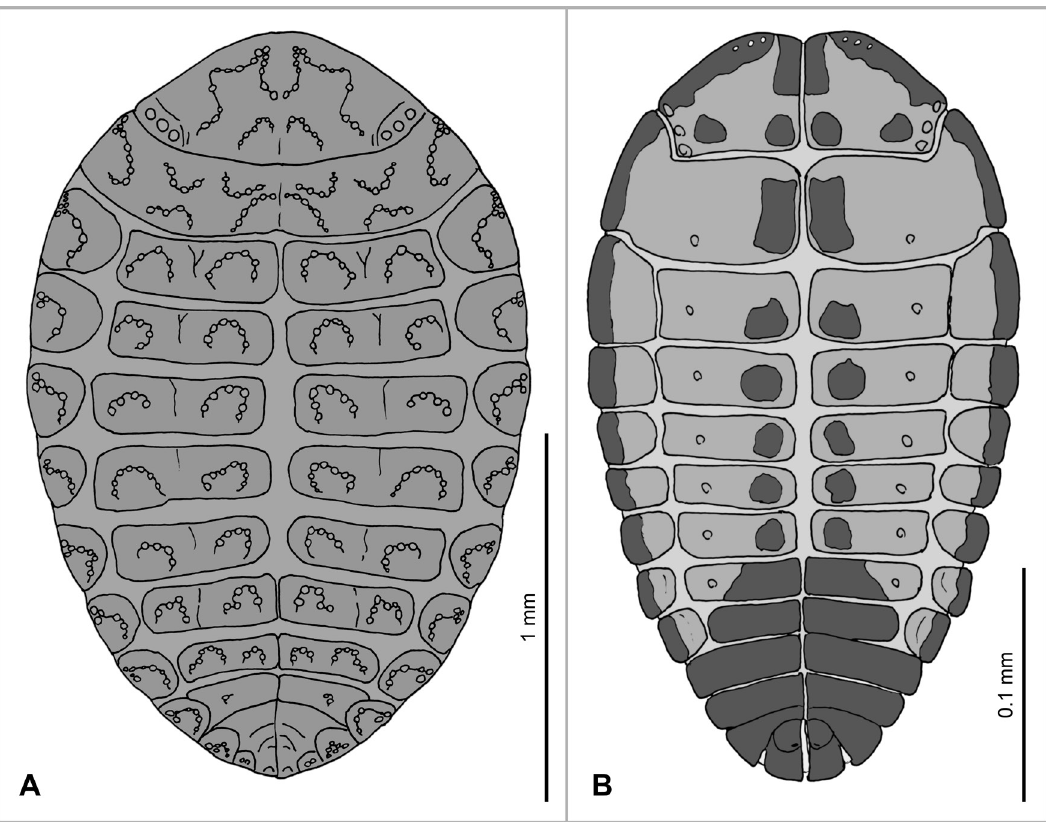
Fig. 44. Adelges (Aphrastasia) pectinatae (Cholodkovsky, 1888). A . Adult progrediens, showing arrangement of plates and wax gland pits (after Inouye 1953, modified). Note the wax gland pattern, giving rise to ‘half-pipe’-shaped wax filaments. B . Hibernating first instar nymph (neosistens), with wax-exuding areas shaded (after Inouye 1953, modified and redrawn from Pashchenko